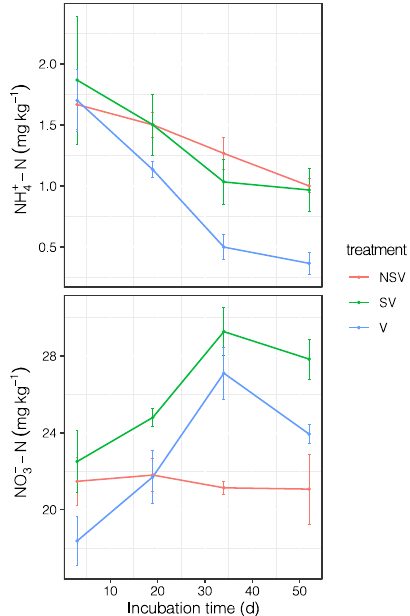
Figure 3. The dynamics of ammonium nitrogen and nitrate nitrogen during the incubation period. Error bars represent the standard error (n = 3).